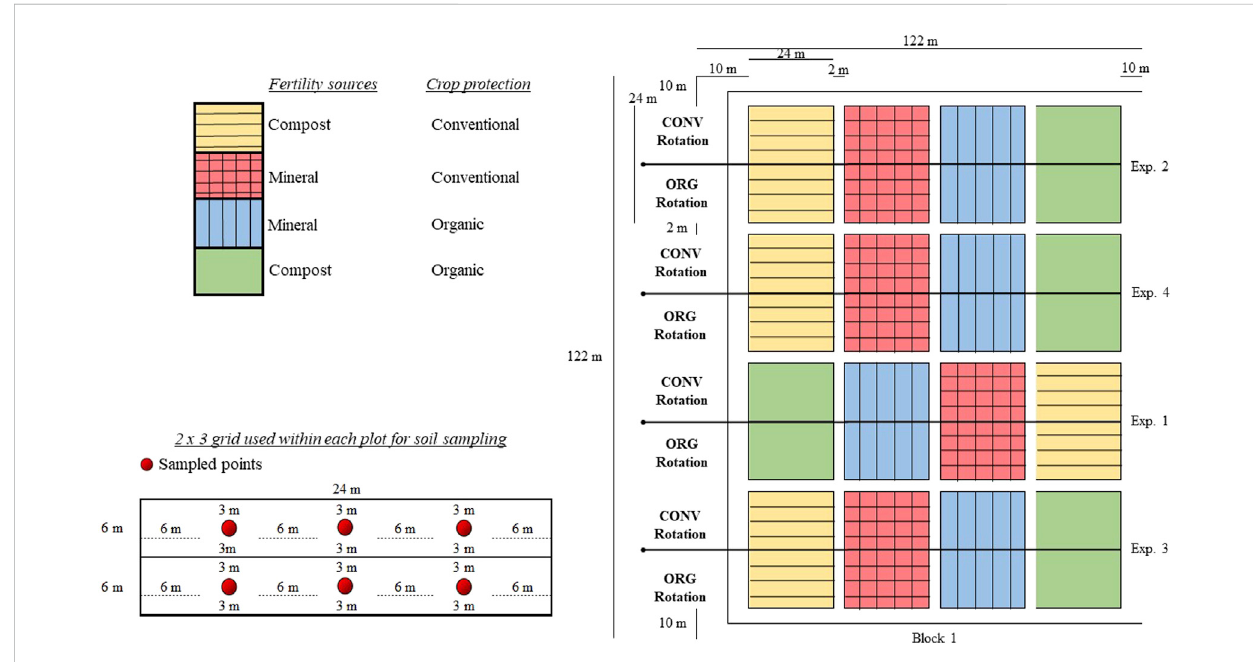
FIGURE 1 NaffertonFactorialSystemsComparison(NFSC)mainblocklayout(122 m×122 m)andexperimentaldesignusedforsoilsampling(bottomleft).The 2 × 3 sampling grid is zoomed in for one-half of the plot layout (i.e. 12 × 24 m). Schematic soil sampling location within each half-plot is represented by red points. Crop rotation is divided into conventional (CONV) and organic (ORG) rotation levels. The main block layout is repeated four times in the fi eld. Exp. refers to experiments (1, 2, 3, and 4). Full layout design is provided in Supplementary Figure